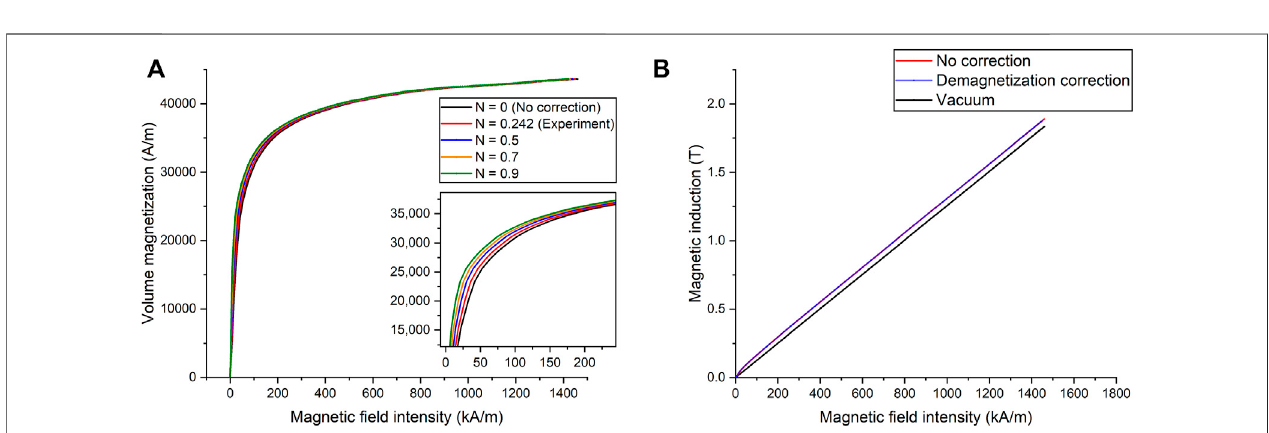
Frontiers in Materials |